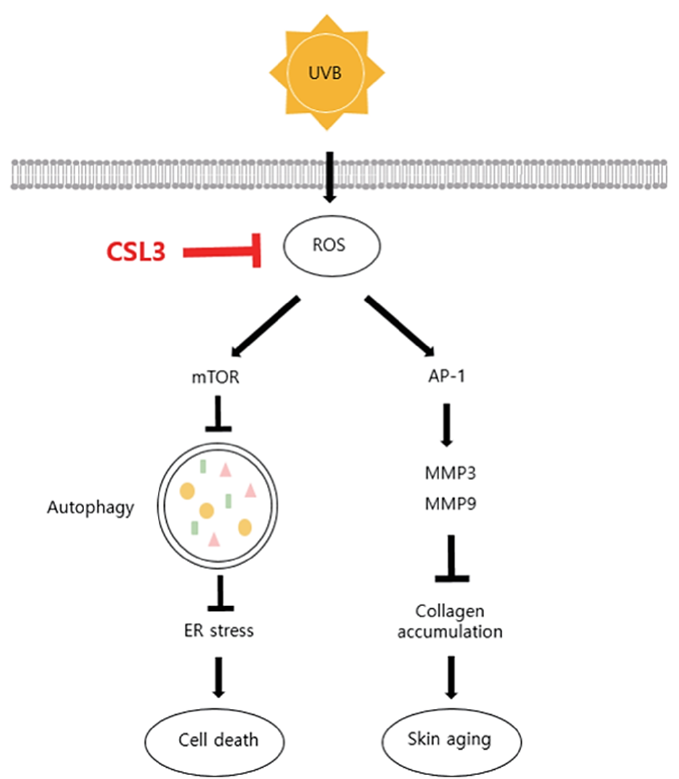
Figure 9. Schematic diagram illustrating the mechanism of CSL3 that protects against skin aging induced by UVB.